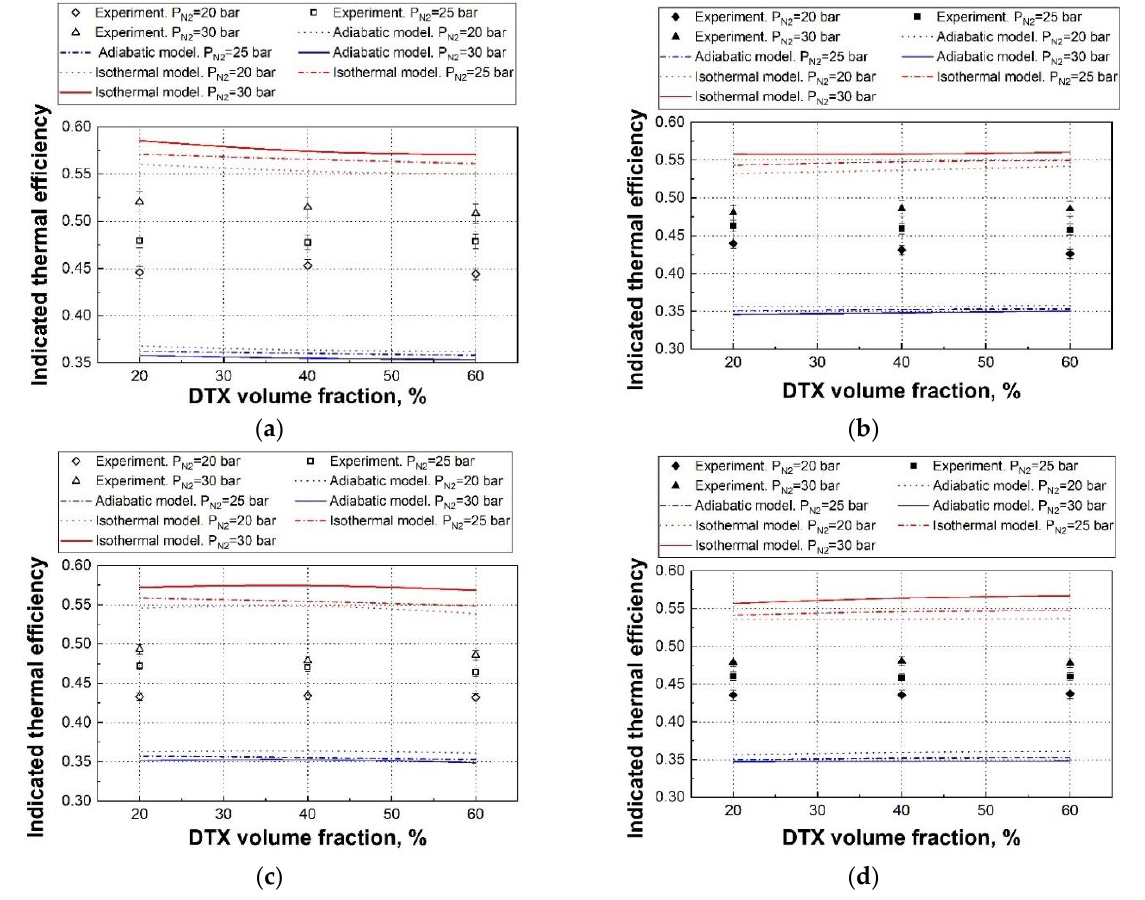
Figure 10. Comparison between experimental and modelled indicated thermal efficiencies at different operation conditions: ( a ) N = 600 rpm, T HEF = 30 ◦ C; ( b ) N = 600 rpm, T HEF = 60 ◦ C; ( c ) N = 700 rpm, T HEF = 30 ◦ C; ( d ) N = 700 rpm, T HEF = 60 ◦ C.